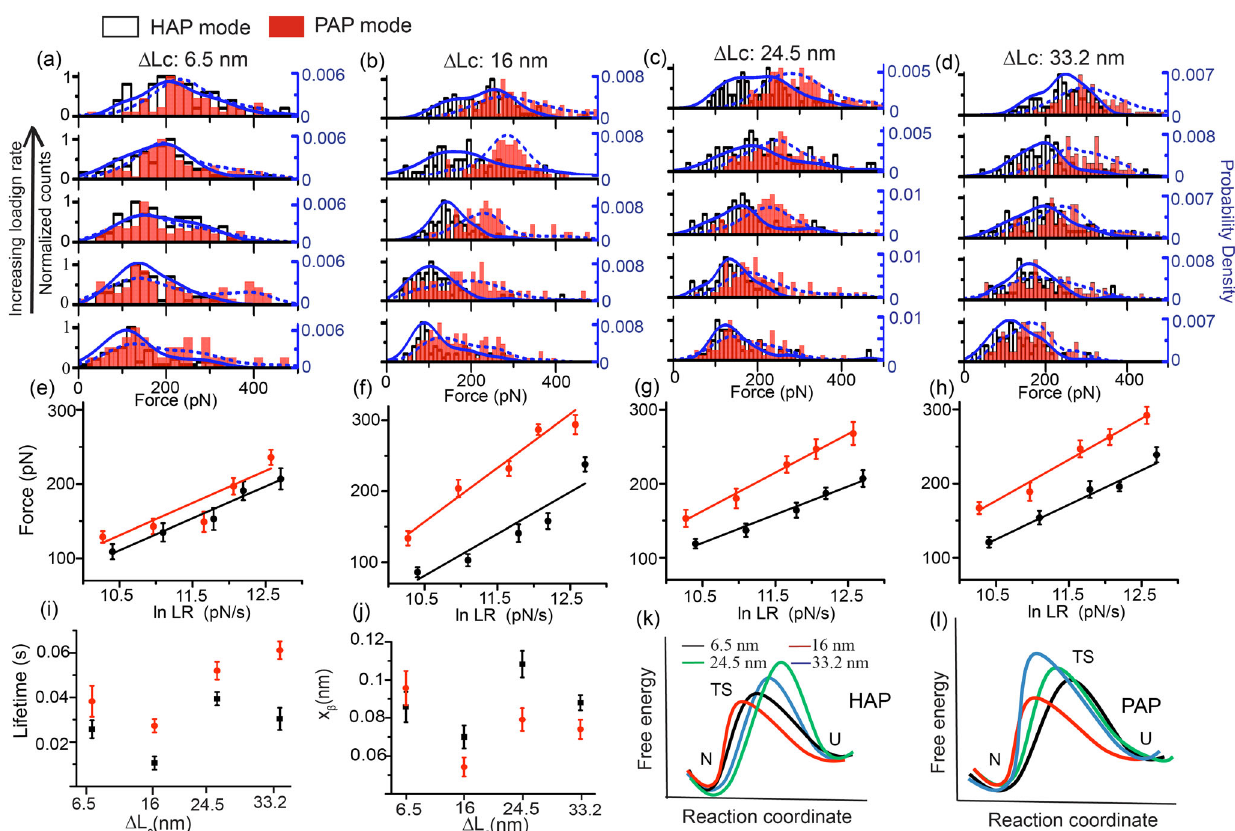
Fig. 2 Cdh23 exhibits higher mechanical tolerance in PAP con fi guration compared to HAP. The distributions of unfolding forces of Cdh23 at different pulling velocities (500, 1000, 2000, 3000, 5000nm s − 1 ) have been plotted for four different extensions of ( a ) ~6.5 nm, b ~16 nm, c ~24.5 nm, and ( d ) ~33 nm for both HAP (black) and PAP (red). The solid and the dashed blue lines are the kernel density estimates (KDE) for HAP and PAP, respectively. The most probable unfolding forces are chosen from the maximum counts in the KDE. e – h The monotonous increase in the most probable unfolding forces with loading rates (loading-rate = pulling velocity × spring constant of the cantilever) is plotted for four different Δ L c s. Errors reported are the standard error. The solid lines are the Bell – Evans model fi t to the force-loading rate data for ( e ) ~6.5 nm, f ~16 nm, g ~24.5 nm, and ( h ) ~33 nm. i and j Distributions of the intrinsic lifetime ( τ off ) and x β of all four extensions are shown respectively for HAP (black) and PAP (red) (mean ± SD from n = 3 independent experiments). k and l Schematics of potential energy barriers for extensions of Cdh23 of ~6.5 nm (black), ~16 nm (red), ~24.5 nm (green), and ~33 nm (blue) are drawn as per the kinetic parameters for HAP and PAP,